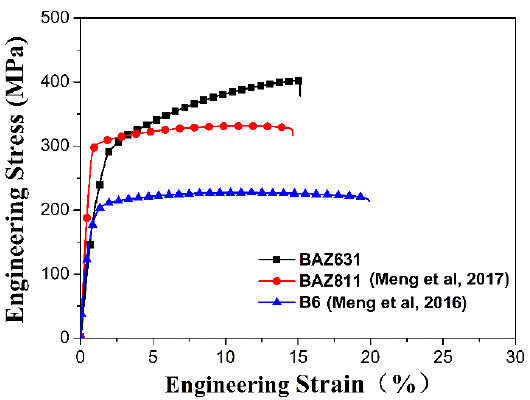
Figure 5. Figure 5. Typical tensile stress-strain curves of as-extruded BAZ631 alloy, compared with B6 and BAZ811.